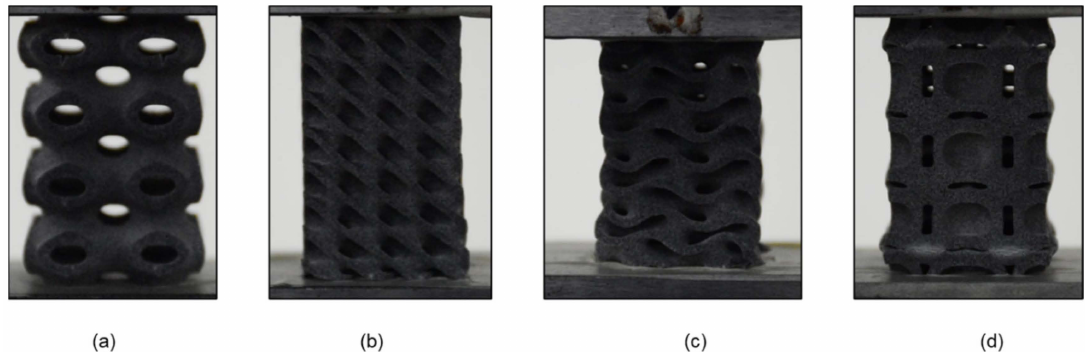
Figure 5. Configuration samples at 2 × 2 × 4 at uniform deformation. ( a ) At this stage, the Schwarz-P sample shows deformation in holes as the shape of the hole’s changes from circular to parabola. ( b ) Diamond design deforms in the share plane. ( c ) Gyroid samples show layer by layer deformation and act like spring. ( d ) Neovius structures show deformation in stress concentration points from where the crack